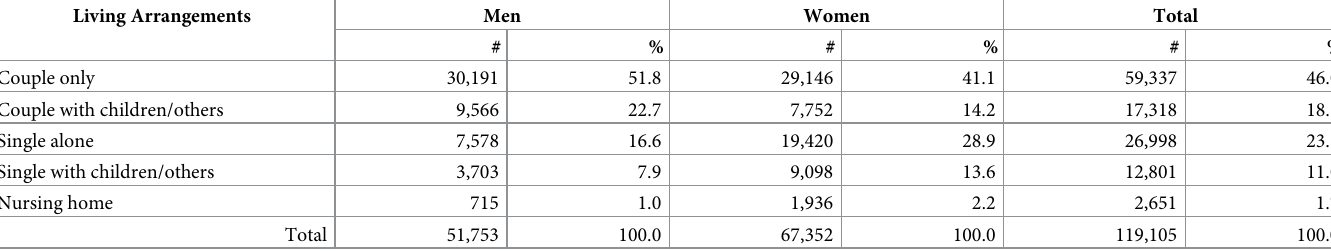
Table 1. The numbers of interview records of living arrangement by gender for non-Hispanic whites. Living Arrangements